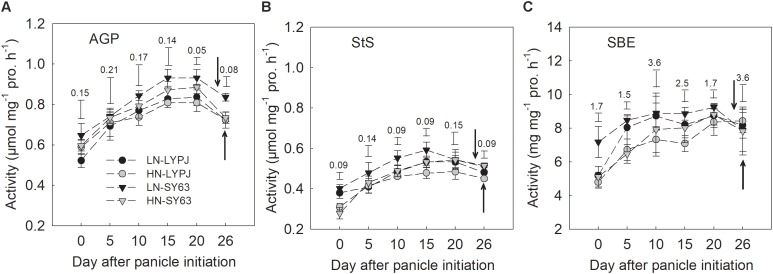
Activities of AGP (A), StS (B), and SBE (C) in the stems of LYPJ and SY63 cultivars under LN and HN treatments. Vertical bar with number represents LSD0.05 for difference significance of mean among 4 combinations at an identical time point. The downward and upward arrows indicate HD under LN and HN. Data are shown as mean ± standard error (n = 3).